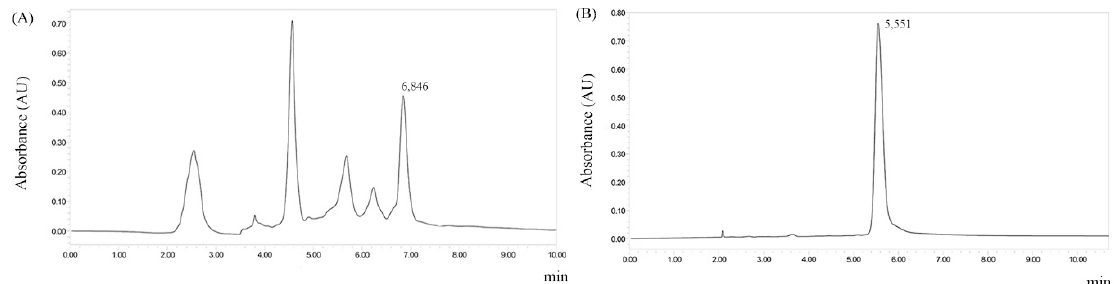
Figure 2. Chromatographic HPLC profiles of the subfraction F6AF and flavopereirine isolation of ethanolic extract from stem barks of G. vellosii . Condition: SunFire™ Prep. C18 OBD™ 5 μ m 19 × 150